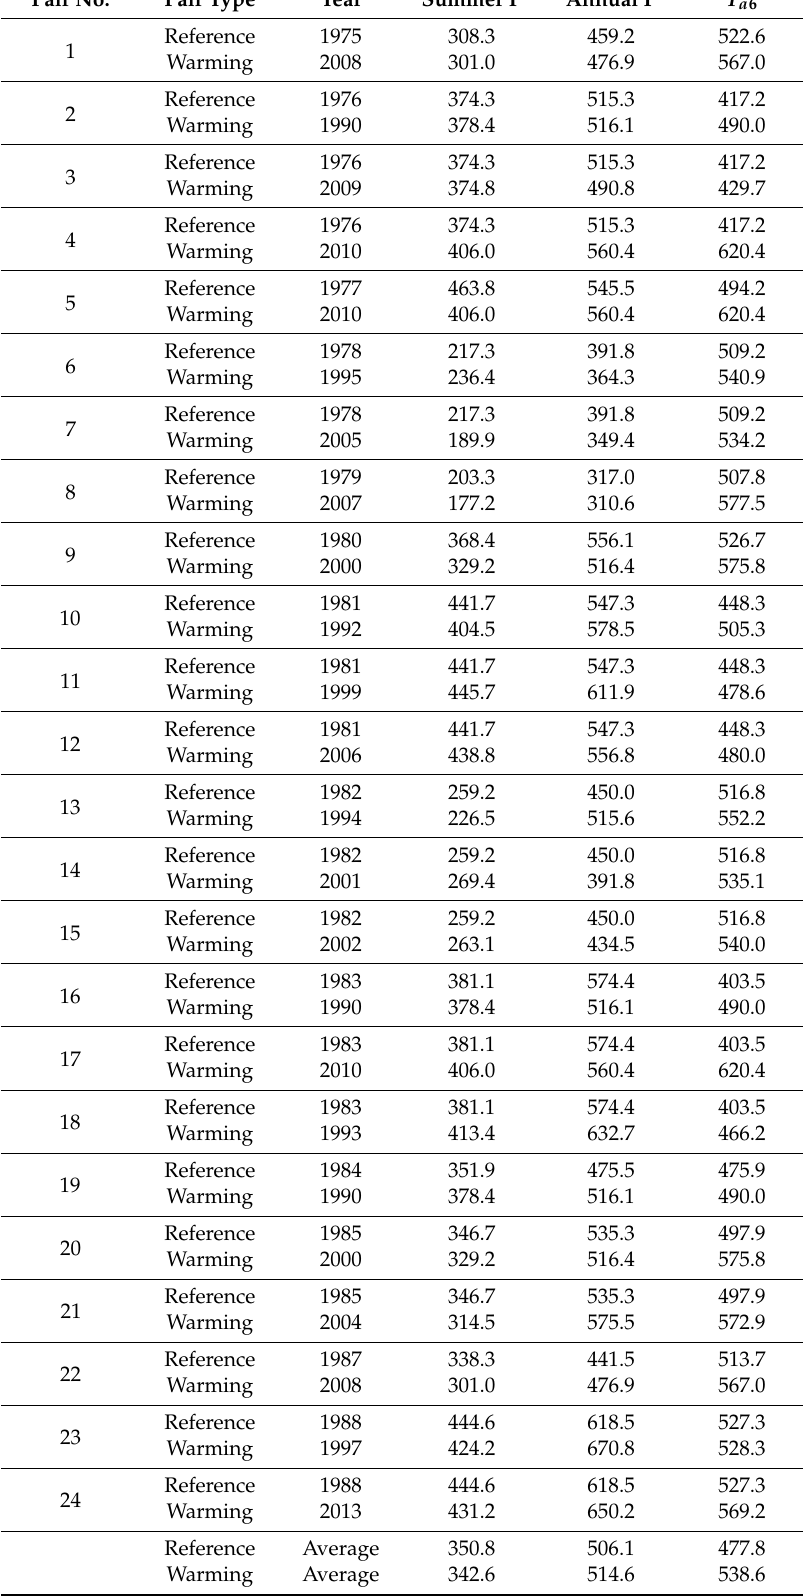
Table A4. Selected pairs for quantifying the effect of climate warming on high flow magnitude in the GR